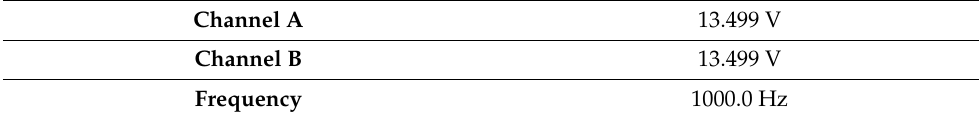
Table 3. Parameters of electron beam oscillation.